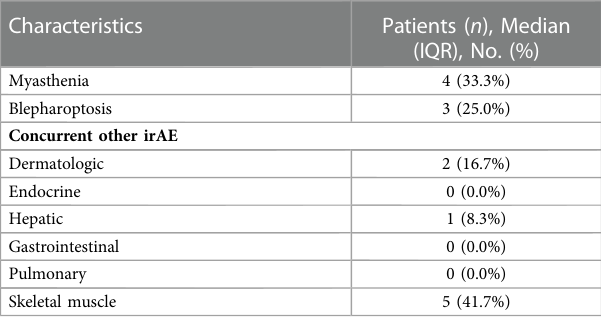
( Figure 2 ). The patients who progressed on prior treatment and had life- threatening complications were admitted to the ICU (8.3%) or treated with mechanical ventilation (8.3%), plasma exchange therapy (8.3%), or an implanted pacemaker (8.3%). No patients received extracorporeal membrane oxygenation (ECMO). Death occurred in 3 (25.0%) patients, with a median time from the initial diagnosis of cardiac irAE to death of 2.0 days (range: 1.0 to 5.0). Another 9 patients (75.0%) were fi nally discharged from the hospital, with a median time from the initial diagnosis of cardiac irAEs to clinical improvement of 29.0 days (IQR: 8.0 –